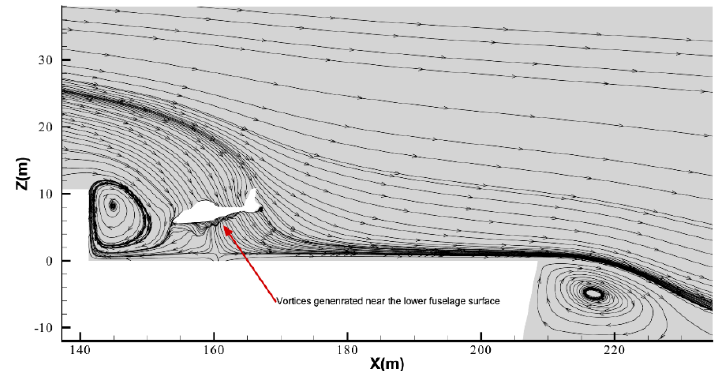
Figure 11. Symmetry plane Streamtrace map under 0 ◦ and 55 km/h WOD condition.